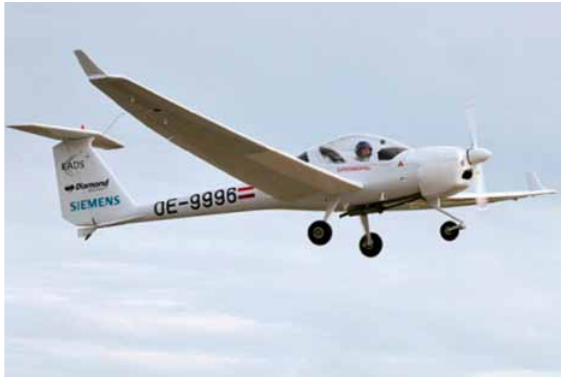
Fig. Siemens DA36 E-Star (Trout